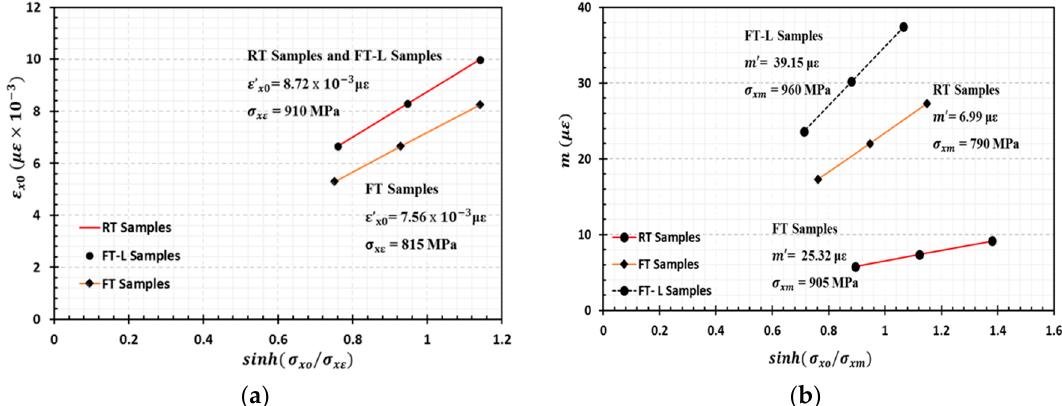
Figure 11. Evaluation of creep parameters ( a ) (cid:2013)’ (cid:3051)(cid:2868) and (cid:2026) (cid:3051)(cid:3084) , ( b ) (cid:2026) (cid:3051)(cid:3040) and (cid:1865)′ .